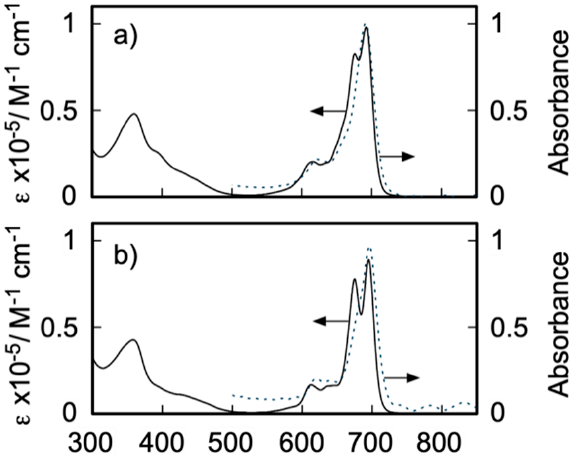
Figure 3. Absorption spectra of PcS27 ( a ) and PcS28 ( b ) in toluene (solid line) and adsorbed onto TiO 2 film (dotted line).